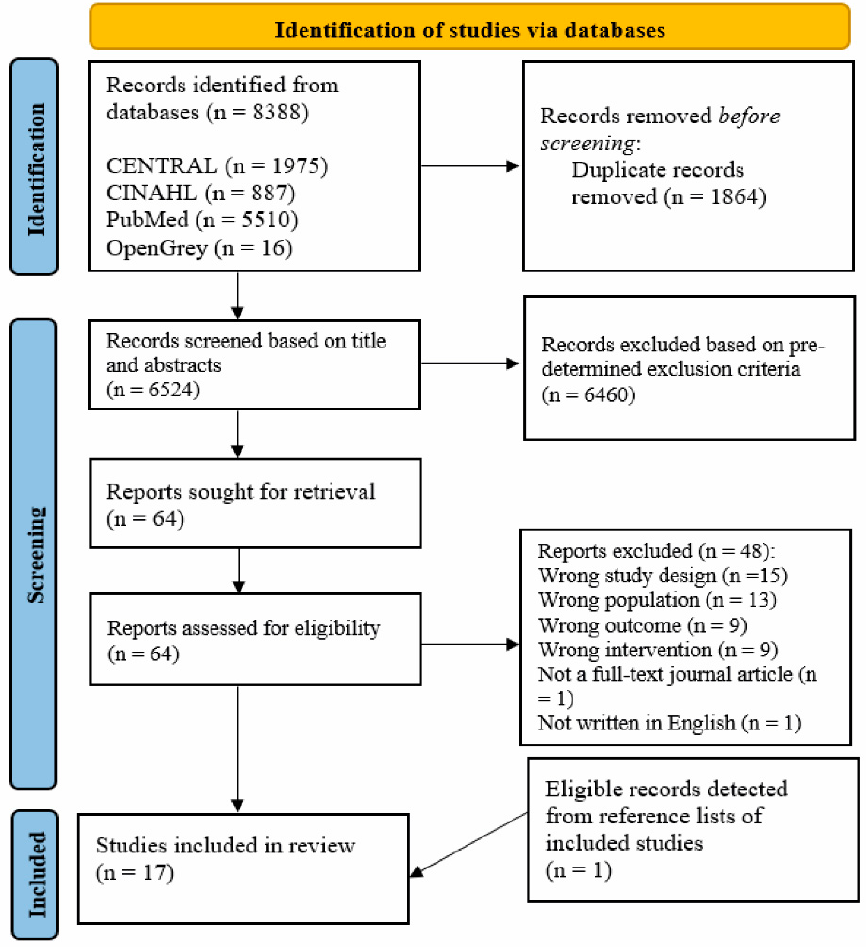
Figure 1. PRISMA 2020 flow diagram.